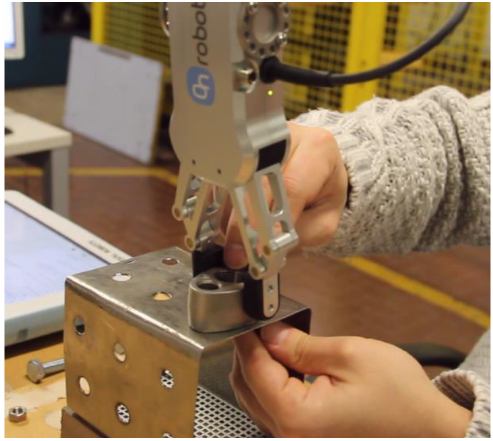
Figure 7. Collaboration during flange joining to the